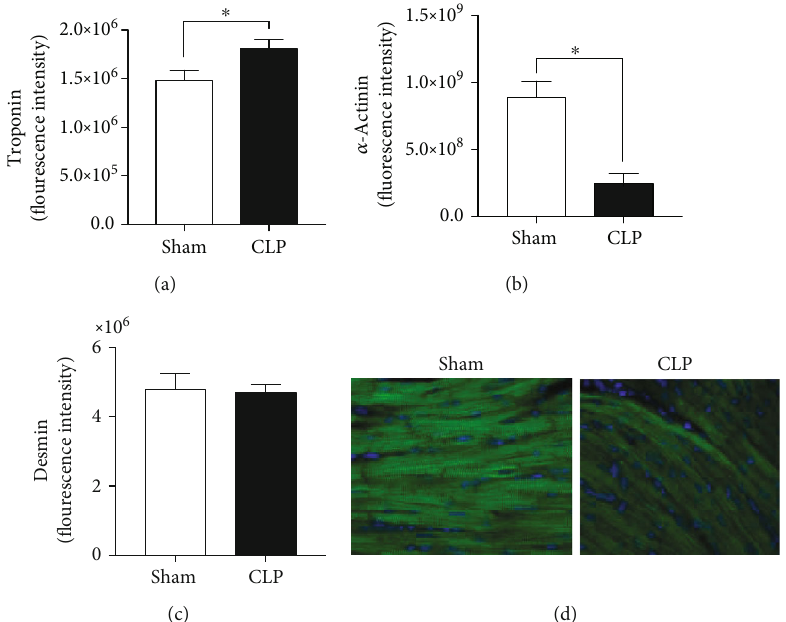
Figure 2: Cardiac structural alterations in vivo in left ventricles of CLP mice: fl uorescence intensities of troponin I (a), α -actinin (b), and desmin (c) and representative picture of α -actinin in left ventricles (d). Mice received either sham treatment (white bars) or CLP treatment (black bars) for 24 h. Left ventricles were collected 24 h after treatment. n = 5 animals per group; ∗ p < 0 : 05 . All values are expressed as mean ± SEM